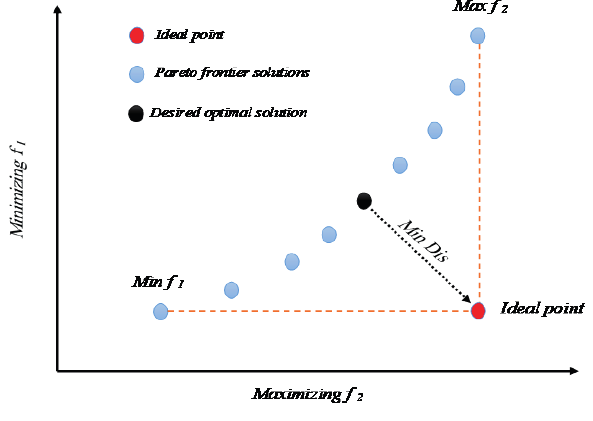
Fig. 2. LINMAP decision making